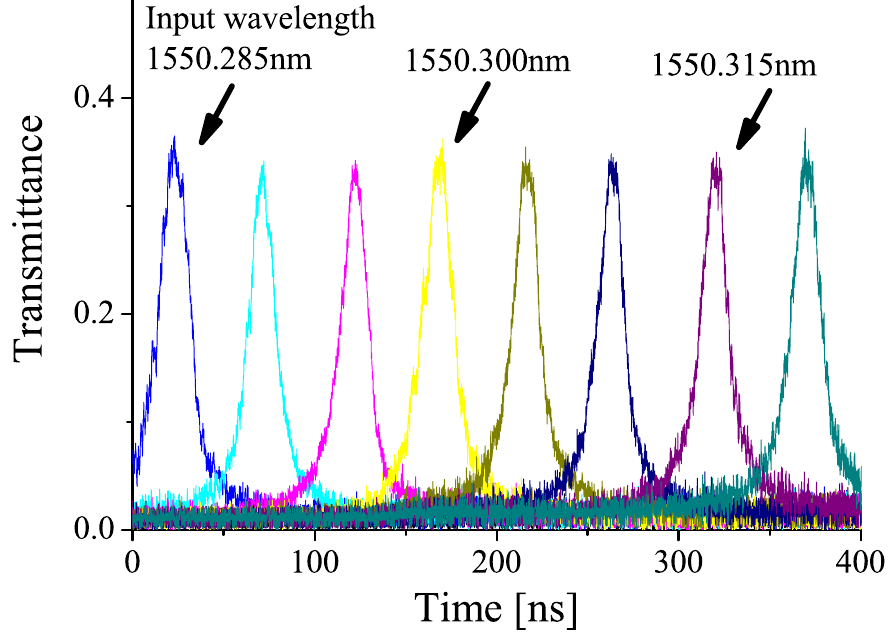
Figure 21. Transmittance of a narrow passband for various input lightwave wavelength, in